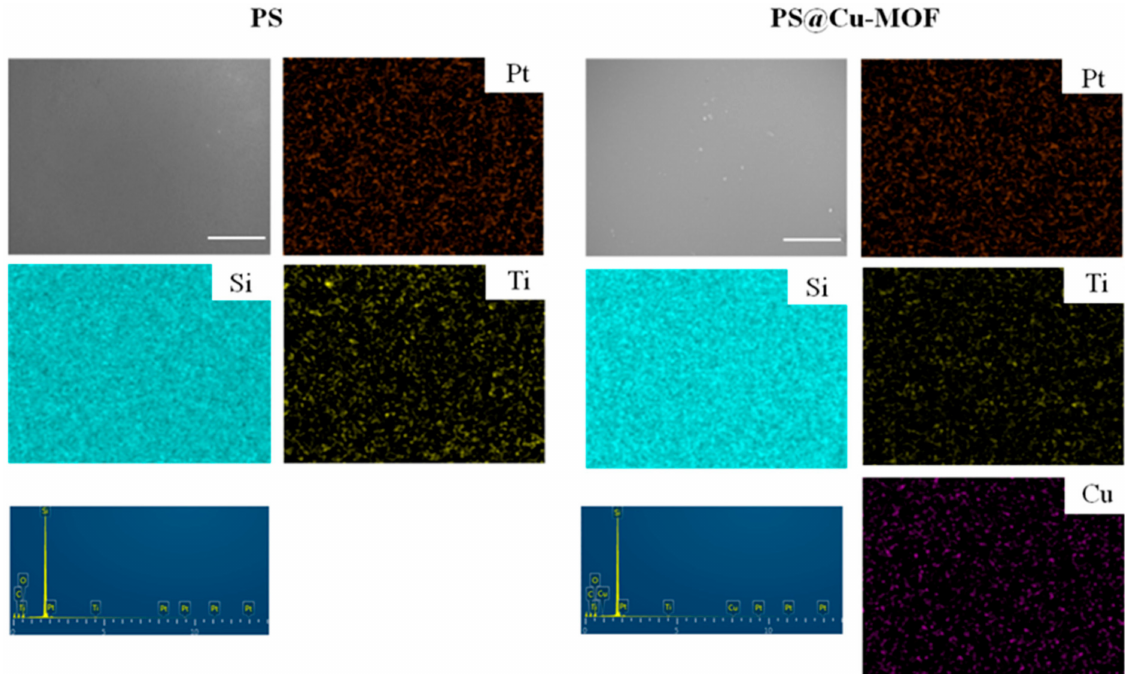
Figure 3. SEM images of PS and PS@Cu-MOF with the accompanying EDS spectra and corresponding elemental maps. Scale bar: 50 µ m.